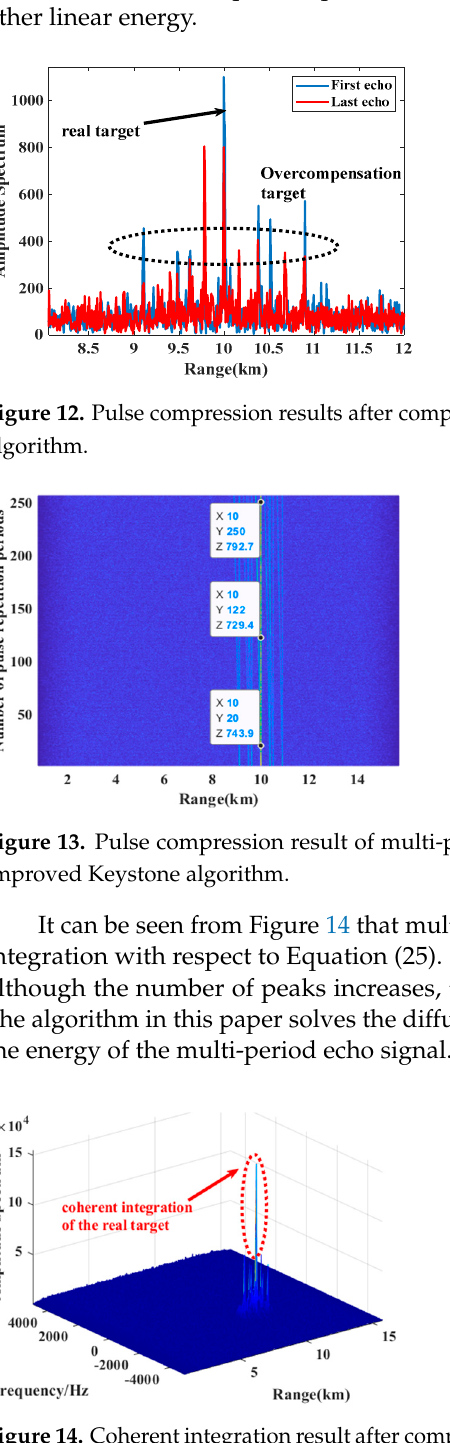
Figure 14. Coherent integration result after compensating based on the improved Keystone algo- rithm.